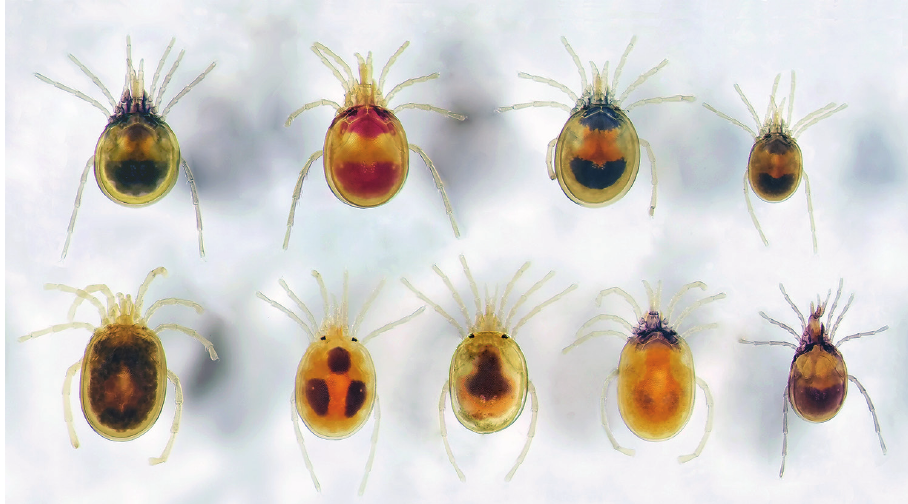
Figure 1. Diversity of Torrenticola in Ouachita National Forest, Arkansas. Species from top-left to bot- tom-right: T. irapalpa sp. n., T. interiorensis sp. n., T. biscutella sp. n. female, T. biscutella sp. n. male, T. pearsoni sp. n., T. trimaculata Fisher & Dowling 2016, T. unimaculata sp. n., T. larvata Cherri et al. 2016, T. solisorta sp. n. Note that, for a given locality, many characters necessary for identification can be seen under low magnification. For example, species in the bottom row can be readily differentiated using color pattern. In contrast, species in the top row have similar color patterns; however, even they can be readily identified: T. irapalpa have dorsal glandularia (Dgl-4) closer together than the other species and T. biscutella have fused anterio-lateral platelets and strong sexual dimorphism (neither character is present in T. interiorensis ). Only the identification of T. interiorensis is tentative based on this image, because T. neoanomala (not pictured), which are also found in this locality, can only be differentiated from T. interiorensis by comparing precise measurements of the anterio-lateral platelets, necessitating examining slide-prepared material under higher magnification. Also, note that some species can appear differently than what is depicted in species descriptions. For example, although T. pearsoni sp. n. has a nearly colorless cuticle, it can appear dark due to gut contents, as shown here. Image is a composite of stacked images from a Samsung GS7 and edited in Adobe